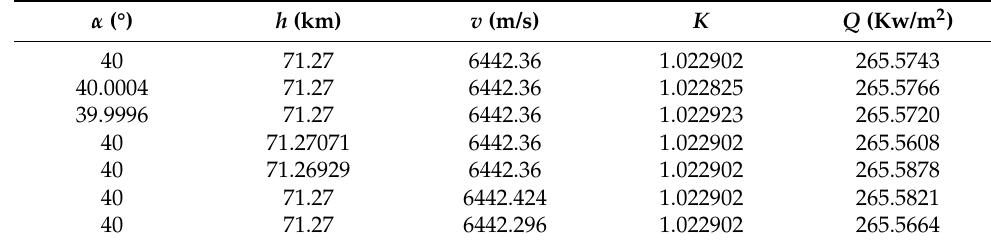
Table 2. Design matrix of DOE and the corresponding aerodynamic